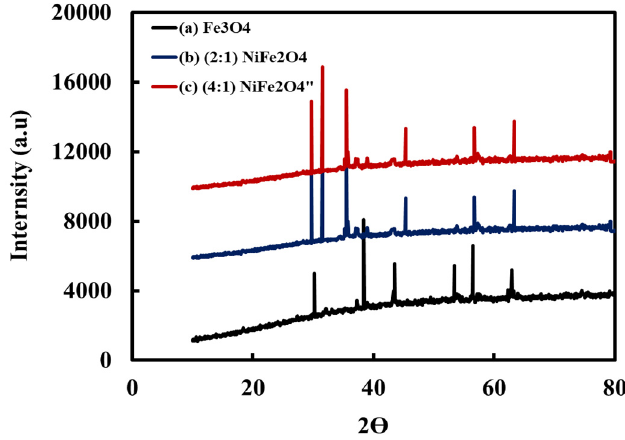
Figure 5. XRD spectra of the synthesized Fe 3 O 4 , and spinel (2:1) and (4:1) NiFe 2 O 4